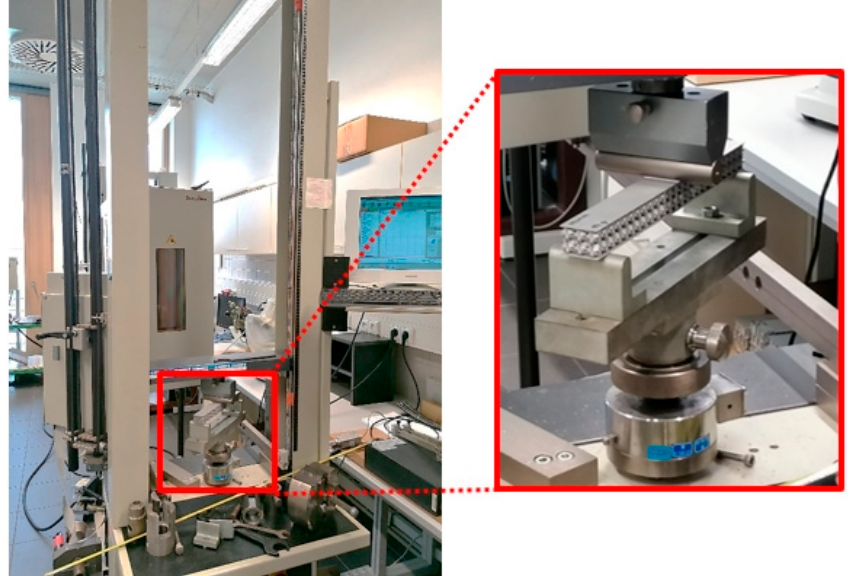
Figure 5. The testing machine ZWICK 1456 with a detail of the sample placed in the test position.